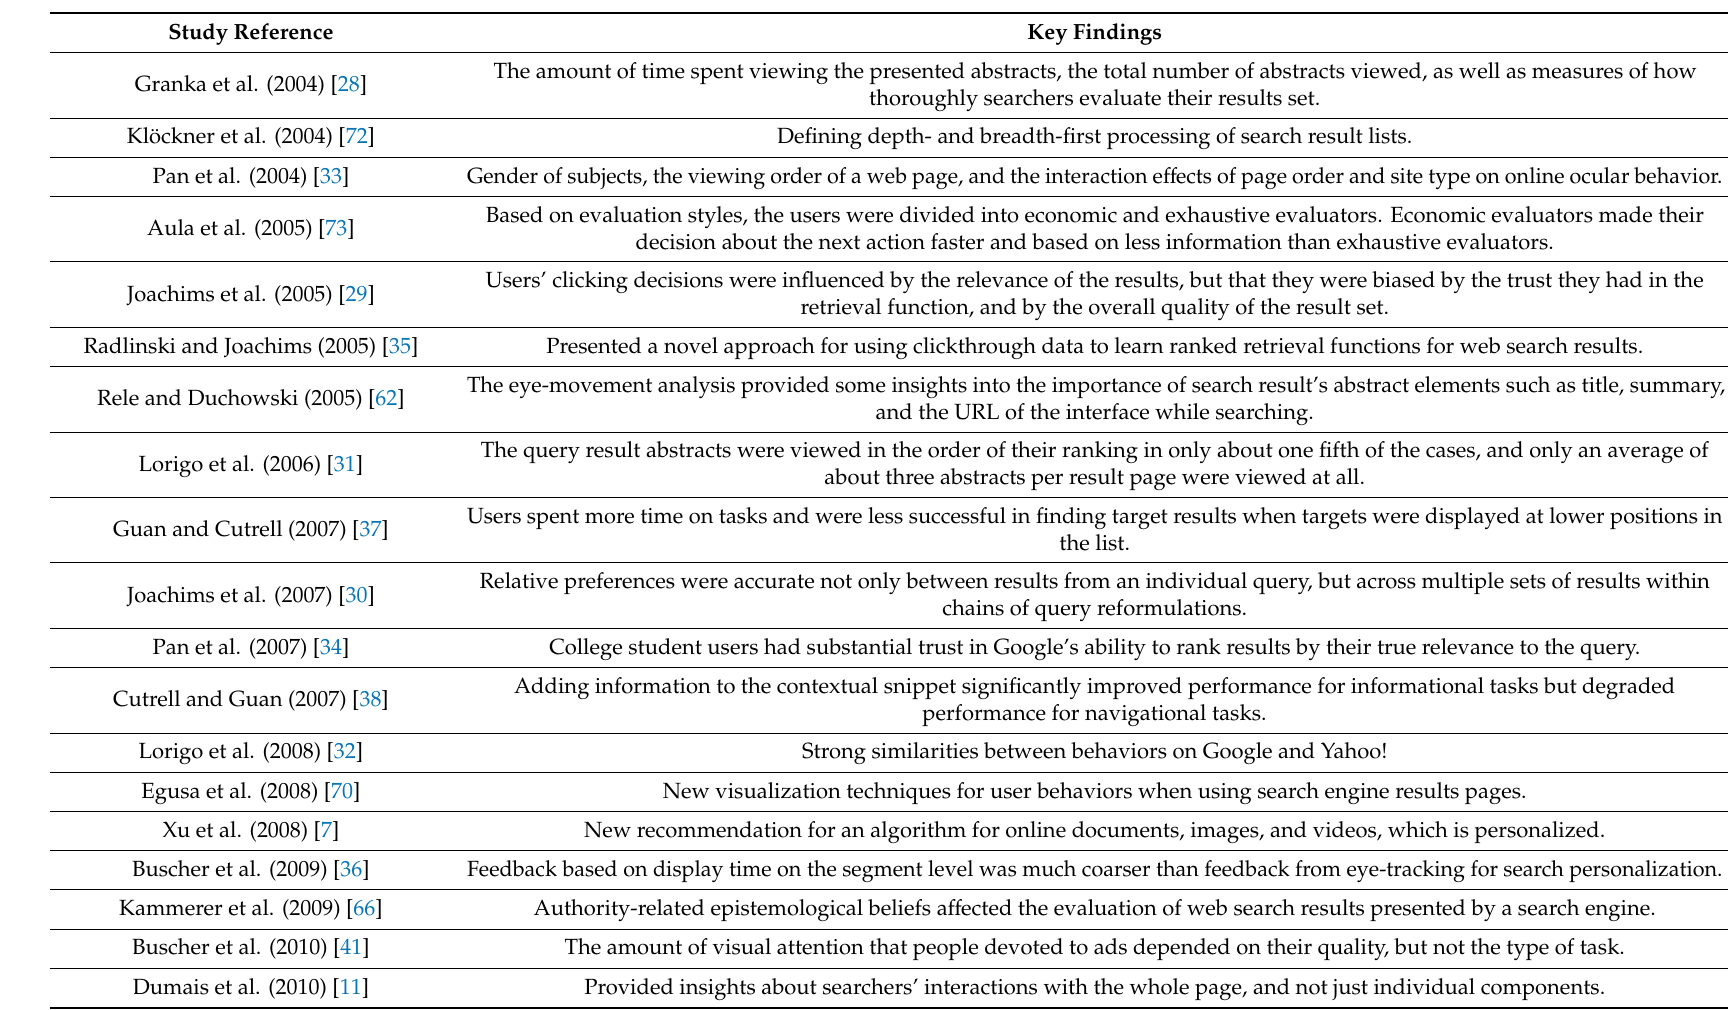
Table 3. Key findings in the reviewed eye-tracking